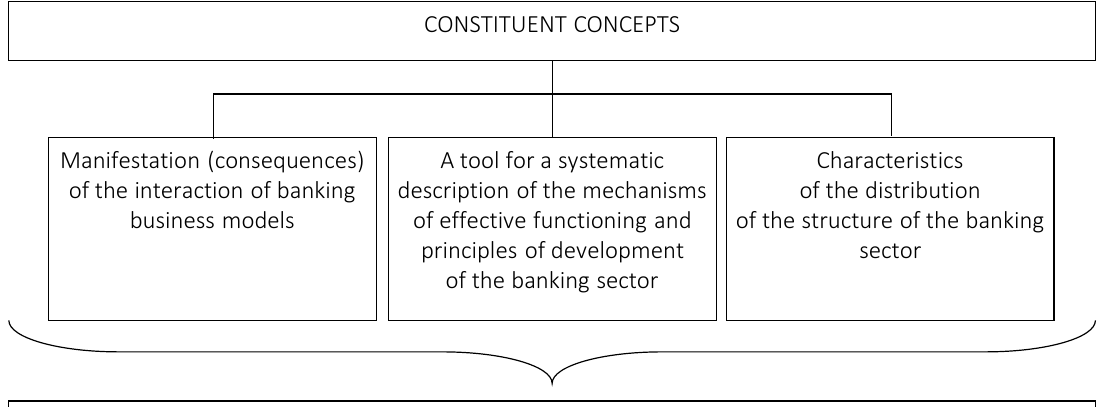
Figure 1. The concept of business architecture of the banking sector of the